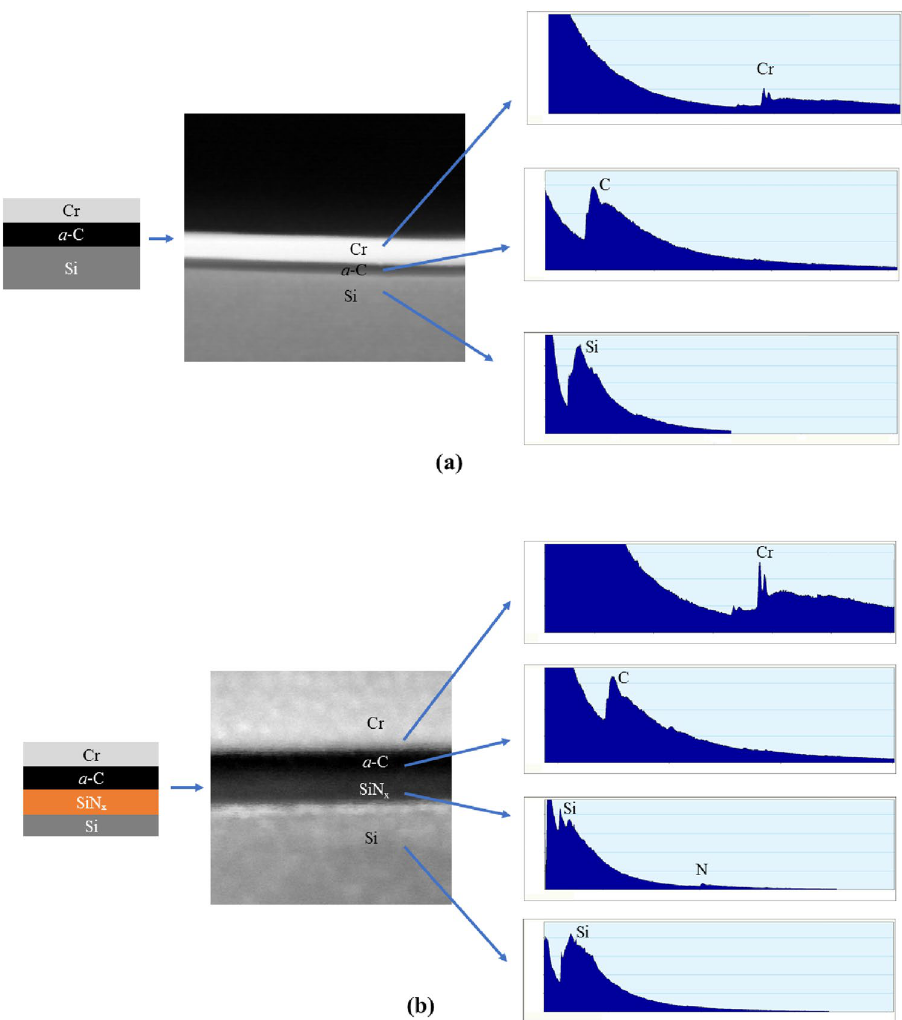
Figure 6. Schematic illustration of the ( a ) a -C/Si and ( b ) a -C/SiN x /Si stacks with the Cr capping layer on top of the overcoat and their corresponding STEM micrographs, accompanied by full survey EELS spectra of each layer present in the two layered stacks. (The vertical and horizontal axes in the EELS spectra represent counts and electron energy loss in eV,